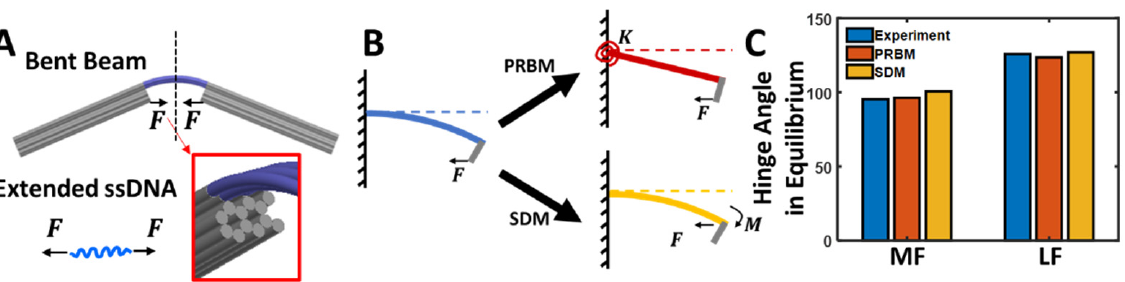
Figure 5. ( A ) The CHJ vertex is modeled as a symmetric bent beam. The extension force of the ssDNA linker balances the force required to bend the beam. ( B ) The symmetric bent beam is further simplified by PRBM or SDM. Both capture the deflection of the beam at the end, which defines the hinge angle. PRBM replaces the bent beam as the combination of a torsional spring and a solid beam. SDM applies a small-angle approximation, assuming small deformation (i.e., the beam is only under a pure bending moment and the buckling force effect is negligible). ( C ) Both models result in good agreement with experimental data for MF and LF. HF was not included in the modeling as the springs had 0 ssDNA length. The standard error from experiment data was less than 1°, which is not shown in the bar plot (for a detailed geometrical description of the HF version, please refer to Supplementary Figure S6).